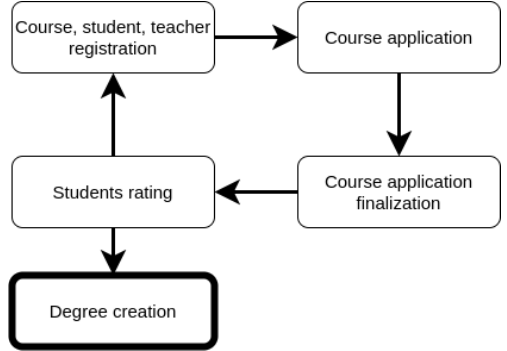
Figure 4. The states of the PoC application.